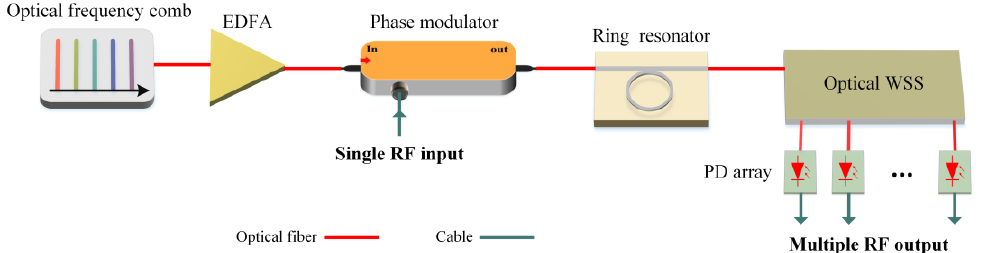
Figure 2. The experimental setup. Optical frequency comb boosted by EDFA is phase-modulated and then notch-filtered by a ring resonator. After optical WSS, each optical branch is recovered to a RF signal. The RF channels are separated by multiple PMIM conversions, while they are directed according to the optical WSS.